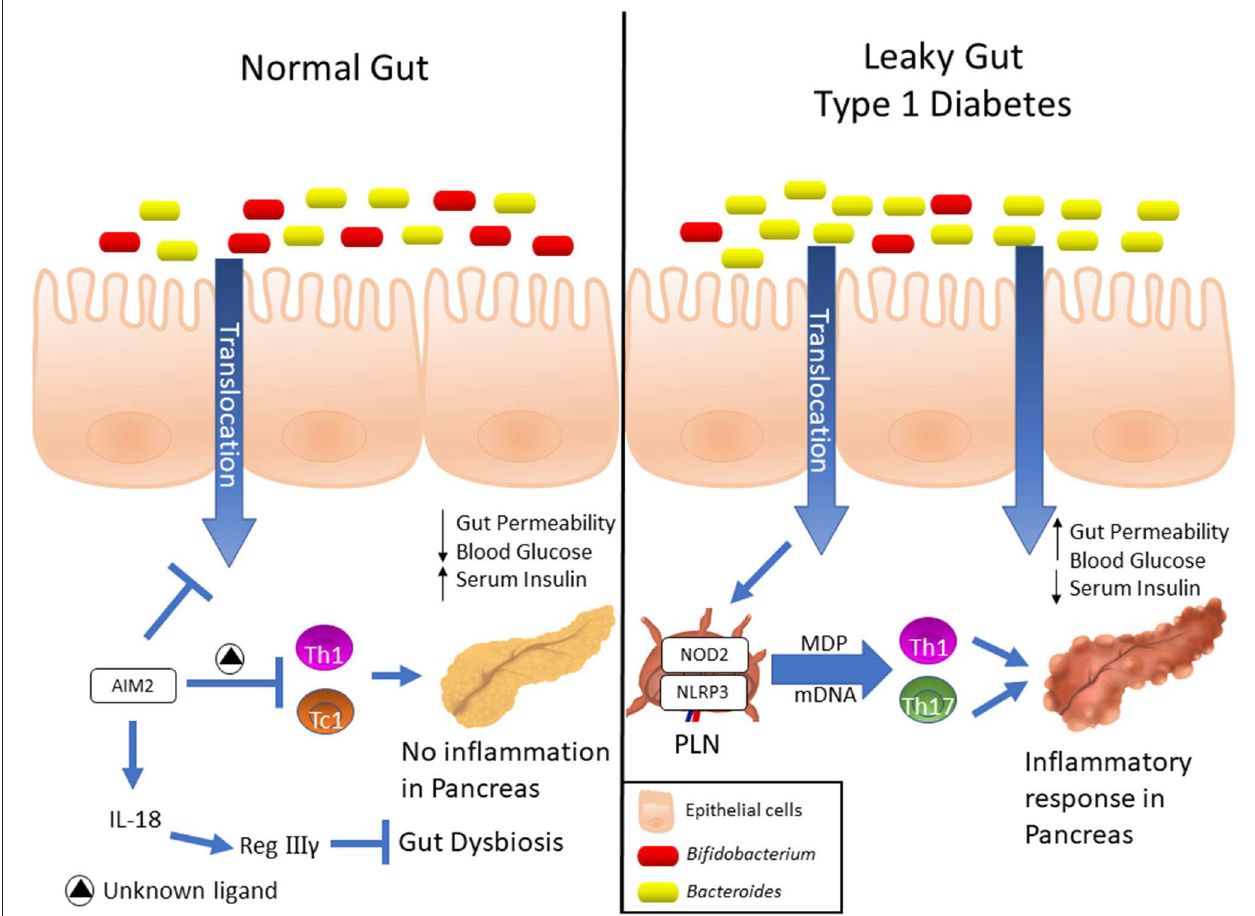
FIGURE 1 | Expression and differential functions of NLRs in Type 1 diabetes development. Elevated AIM2 expression was detected into intestinal mucosa of pre-diabetic mice, and its activation induces the IL-18 release, which in turn, promotes the RegIII γ production. This mechanism attenuates the gut dysbiosis, reinforces the gut barrier and dampens the Th1 and Tc1 lymphocyte response against insulin-producing β cells, which ultimately protects against T1D. On the other hand, NOD2 recognizes translocated muramyl dipeptide (MDP) from dysbiotic microbiota, and contributes to the activation of Th1 and Th17 lymphocytes in T1D. Finally, upregulation of NLRP3 expression in PLNs was observed in diabetic mice, which is activated in macrophages by recognition of mitochondrial DNA (mDNA), leads to IL-1 β production and drives the pathogenic Th17 and Th1 lymphocyte generation, resulting in T1D